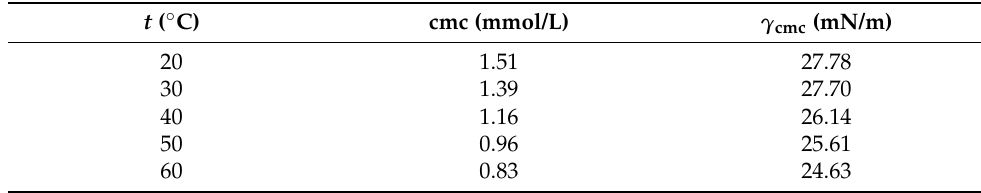
Table 2. Critical Micelle Concentration and Surface Tension of GTA-m-CS/DDEAC Systems with GTA-m-CS Concentration of 1200 mg/L and Different